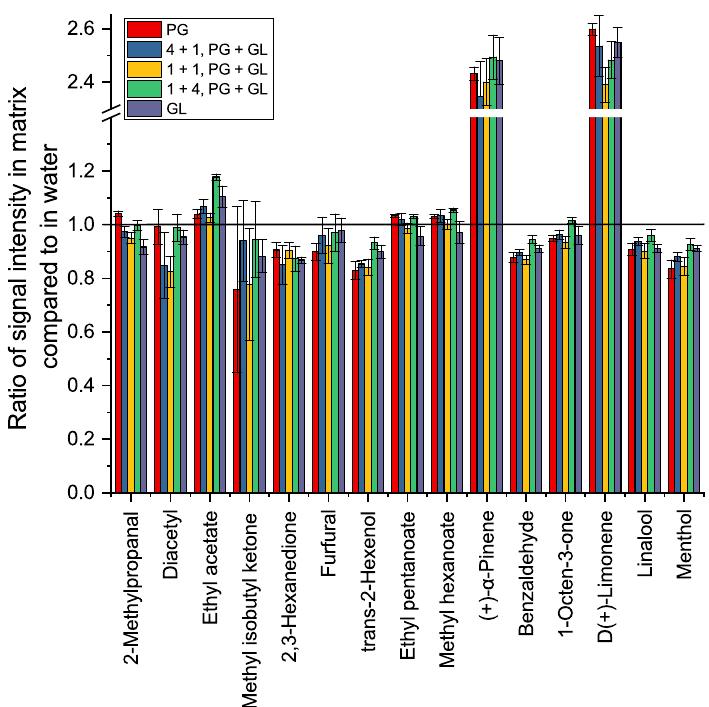
Figure 6. The signal intensity ratio for selected analytes in a range of possible matrices consisting of propylene glycol and glycerol, compared to in water for spiked samples of 5 µg/g matrix and quadruplicate